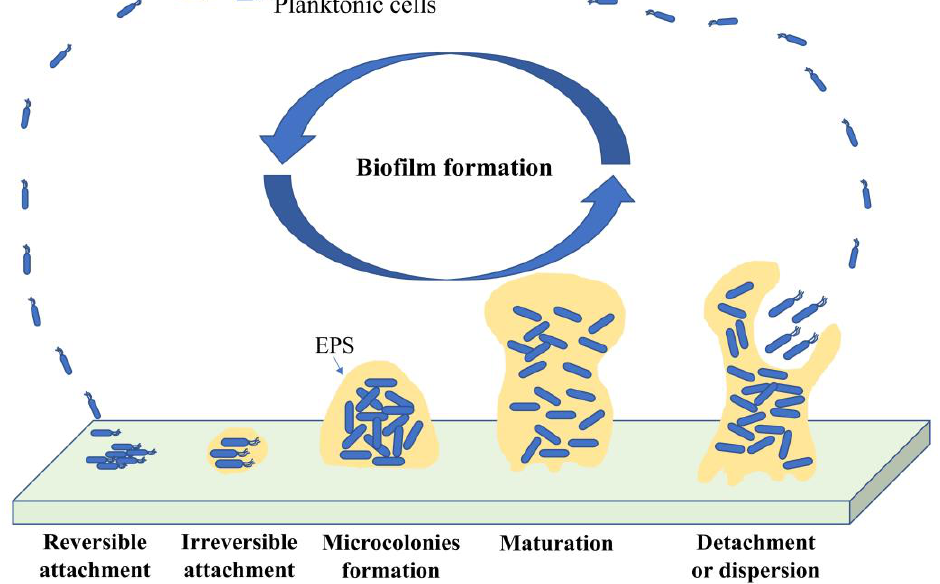
Figure 3. Schematic diagram of different stages in biofilm development .